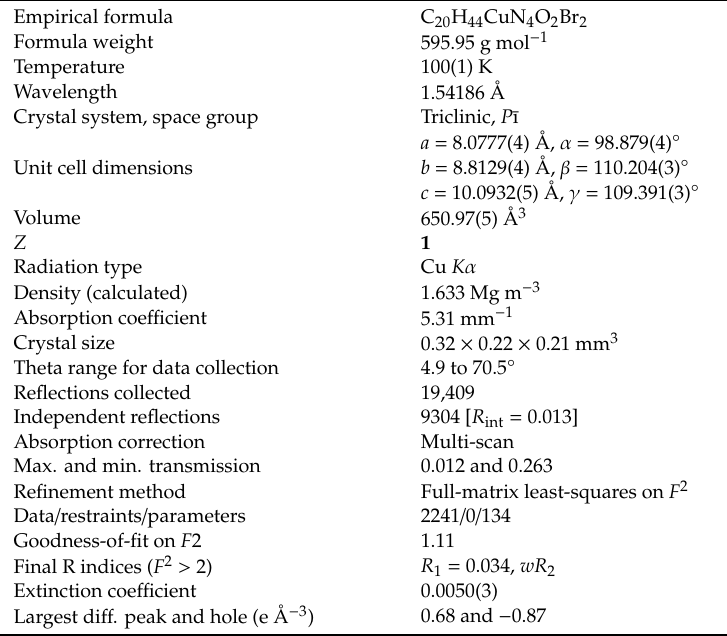
Table 1. Crystal data, data collection conditions and refinements for complex